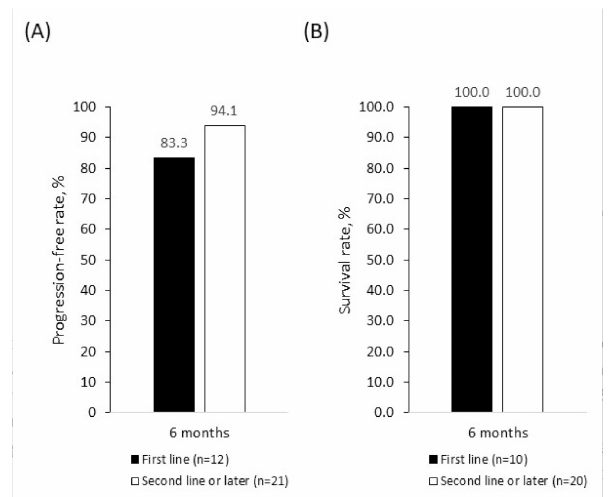
Figure 2. Progression-free rate ( A ) and survival rate ( B ) in patients treated with palbociclib + fulvestrant as first-line or second- and later-line therapy. Rates were estimated using Kaplan–Meier